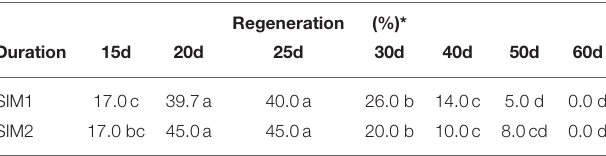
TABLE 7 | Effect of culture duration on shoot induction medium (SIM) on protoplast regeneration of rapeseed.